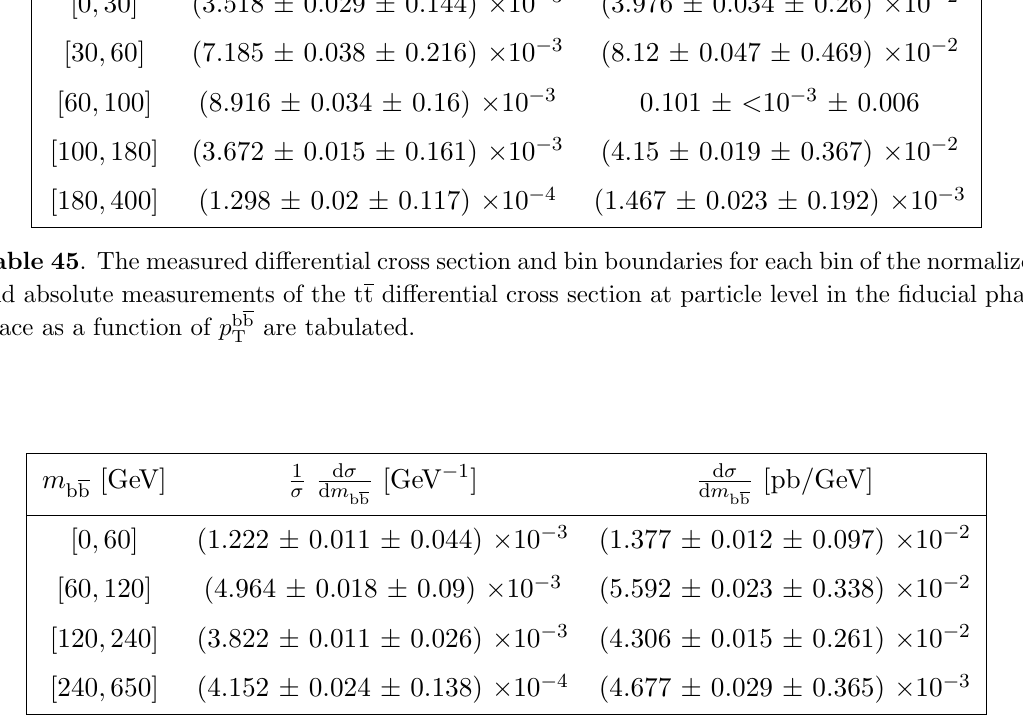
Table 46 . The measured di(cid:11)erential cross section and bin boundaries for each bin of the normalized and absolute measurements of the tt di(cid:11)erential cross section at particle level in the (cid:12)ducial phase space as a function of m are tabulated. bb